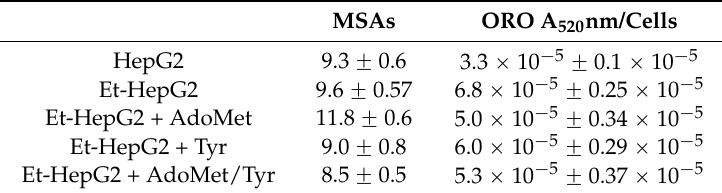
Table 2. Effect of AdoMet, Tyr and AdoMet/Tyr combination on mitochondrial superoxide anions (MSA) and neutral lipid